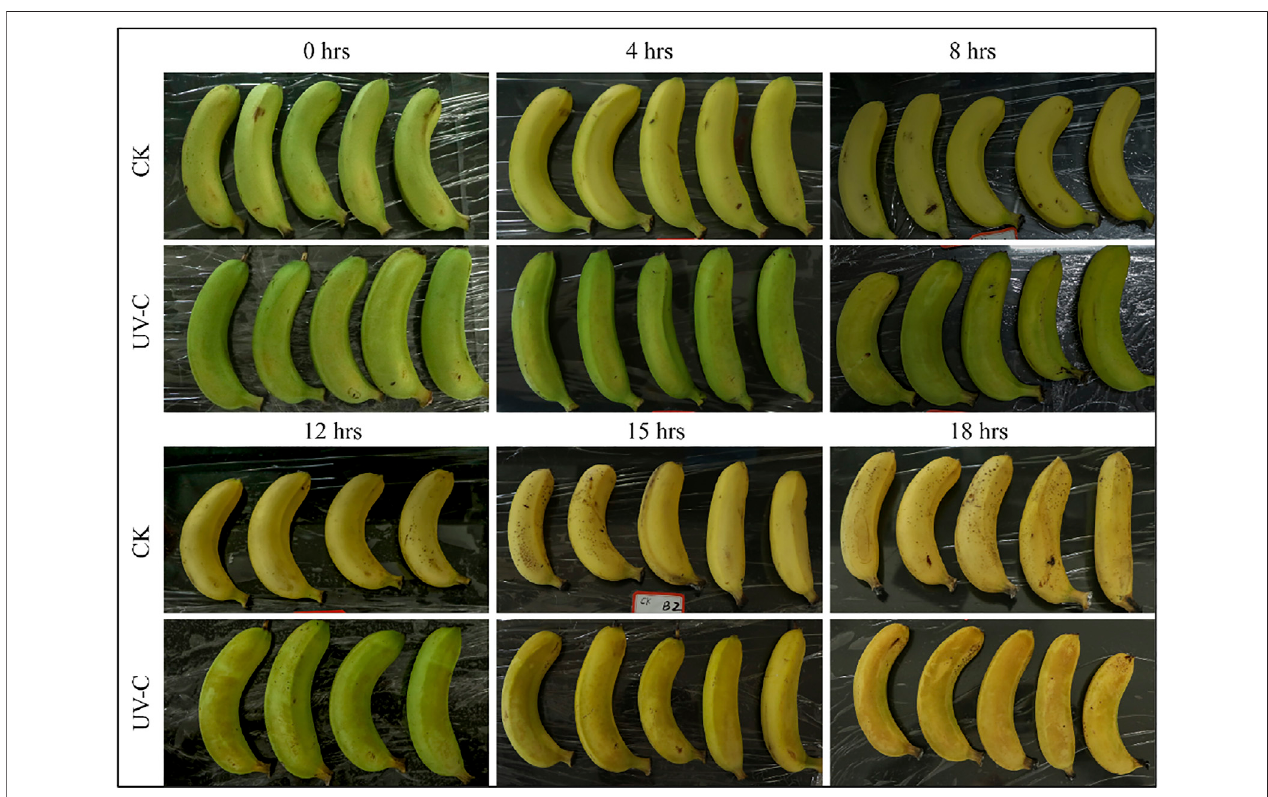
FIGURE 1 | M. nana peel treated with UV-C (0.02 kJ/m 2 ) or without UV-C (CK) for 0, 4, 8, 12, 15, and 18 days.